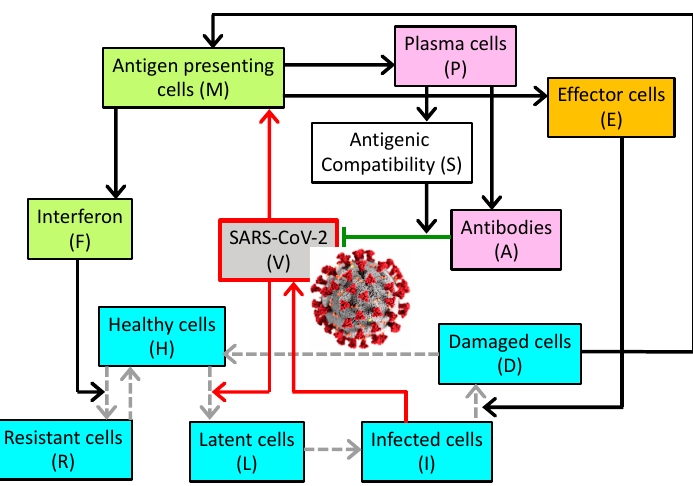
Figure 1. Schematic diagram depicting the interactions among the virus, 5 classes of respiratory epithelial cells (blue boxes), innate immune system (orange), and the adaptive immune system (pink). The conversion from one cell type to another is indicated by gray dashed arrows. Upregulation is indicated by solid black arrows; inhibition by the green line terminated by a bar. Red arrows highlight the direct effects of the virus. The coronavirus image was created at the Centers for Disease Control and Prevention (CDC) and reveals ultrastructural morphology exhibited by coronaviruses.